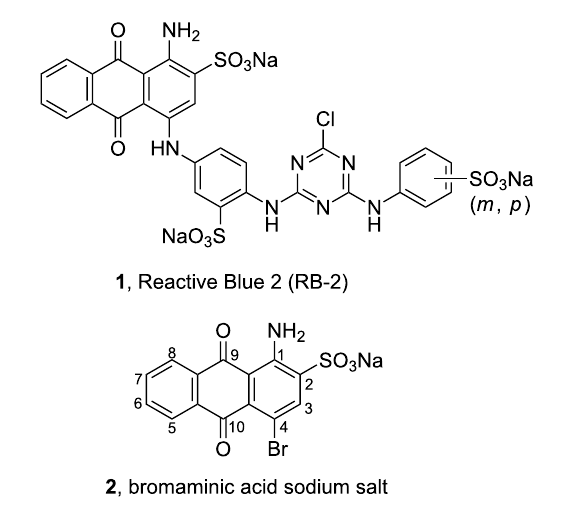
Figure 1: Structures of the anthraquinone derivatives Reactive Blue 2 (RB-2) and bromaminic acid sodium salt.